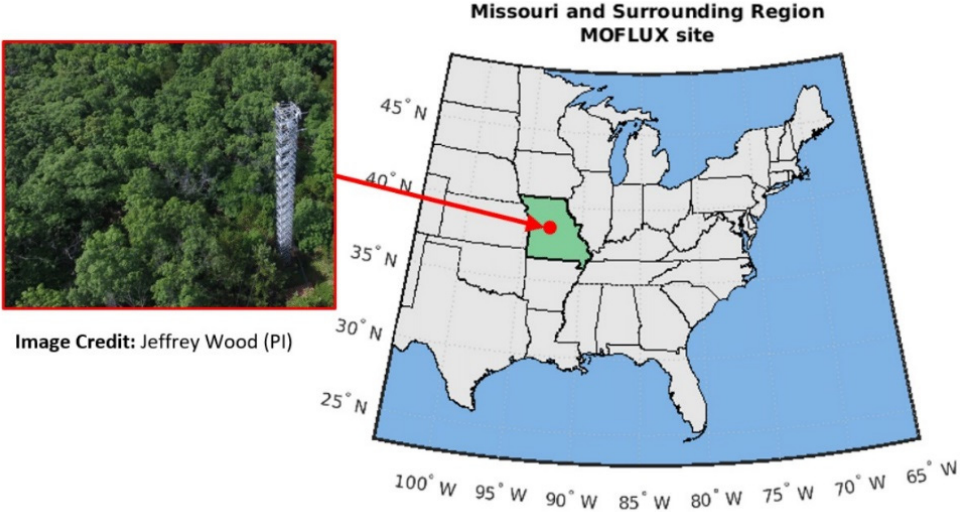
Figure 1. The location of the MOFLUX site in the Missouri state and the 32-m AmeriFlux tower overlooking the forest, approximately 10 m above the top of the canopy.